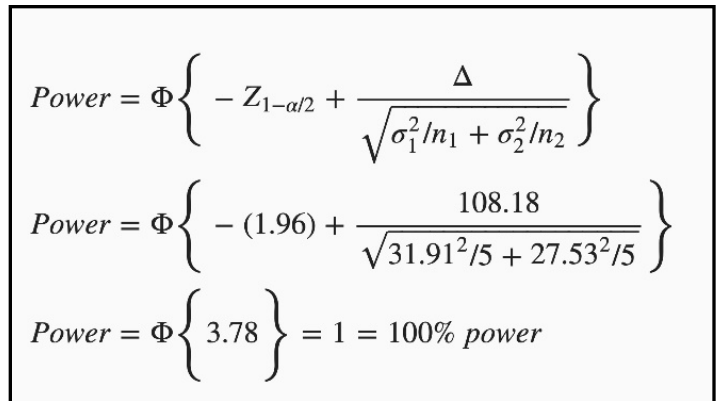
Figure 3. Post hoc power analysis: n1 = sample size for group 1; n2 = sample size for group 2; Δ = | μ 2 − μ 1| = absolute difference between two means; σ 1, σ 2 = variance of means 1 and 2; α = probability of type I error (usually 0.05); β = probability of type II error (usually 0.2); z = critical Z -value for a given α ; Φ () = function converting a critical Z -value to power.